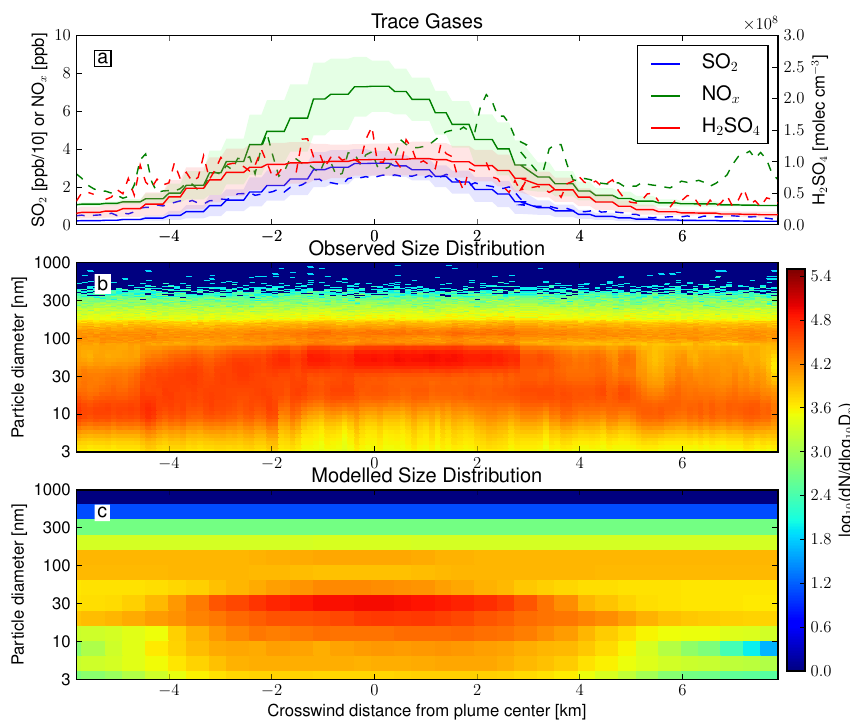
Fig. 2. Trace gas and aerosol concentrations along the second transect north of Parish, about 36km from the power-plant. X-axes show flight track through cross-wind slice of plume. Model resolution is 400 × 400 × 40m. (a) Trace gas concentrations. Observed concentrations as dashed lines, model results as solid lines. Shaded area indicates one standard deviation of the model results, due to turbulent fluctuations. (b) Observed aerosol number size distribution. (c) Modeled aerosol number size